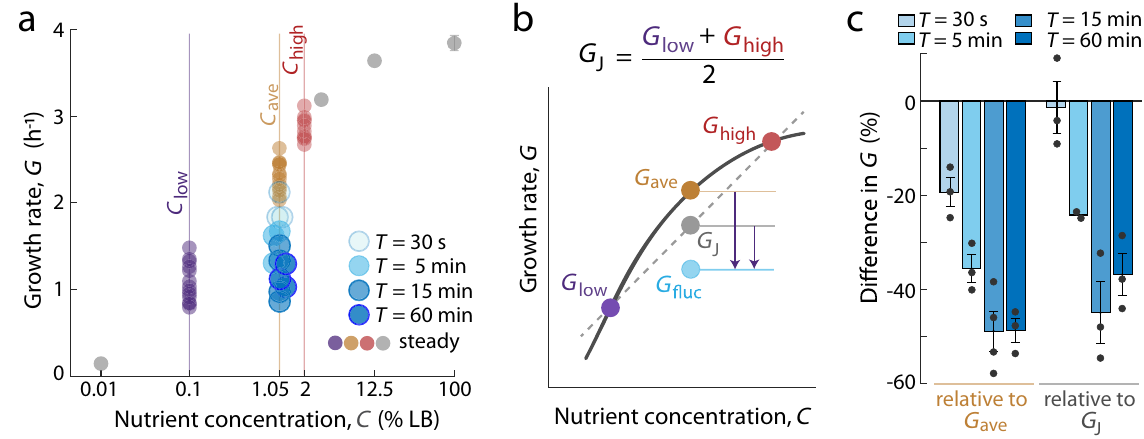
Fig. 3 Rapid nutrient fl uctuations reduce growth rate compared to environments of equal average nutrient concentration. a Cells in fl uctuating environments of various period lengths ( T ) experienced the same time-averaged nutrient concentration as C ave but grew at lower growth rates. Each point represents the mean growth rate of all individual cells measured from all time steps after the initial 3 h of each experiment. Colored points are replicate experiments for steady C low , C ave , or C high or fl uctuating nutrient conditions; gray points are additional steady nutrient concentrations that span the range from nearly zero growth to saturated growth. Error bars denote the standard error of the mean and are smaller than data points when not visible. b Schematic representation of Jensen ’ s inequality ( G ave > G J ) and the relationship between G ave , the growth rate at steady nutrient C ave = ( C low + C high )/2, and G J , the maximum growth rate expected for cells spending equal time at C low and C high . G fl uc in our experiments is below G J . c Percent difference in growth rate for G fl uc at different period lengths relative to a steady-state reference, either G ave or G J . Percent difference was calculated from n = 2 – 4 biologically independent experiments with conditions performed on the same day as ( G fl uc − G ave )/ G ave × 100 or ( G fl uc − G J )/ G J × 100. The raw values used in these calculations are reported in Supplementary Table 6. Data points indicate the difference calculated from each biological replicate. Error bars denote the standard error of the